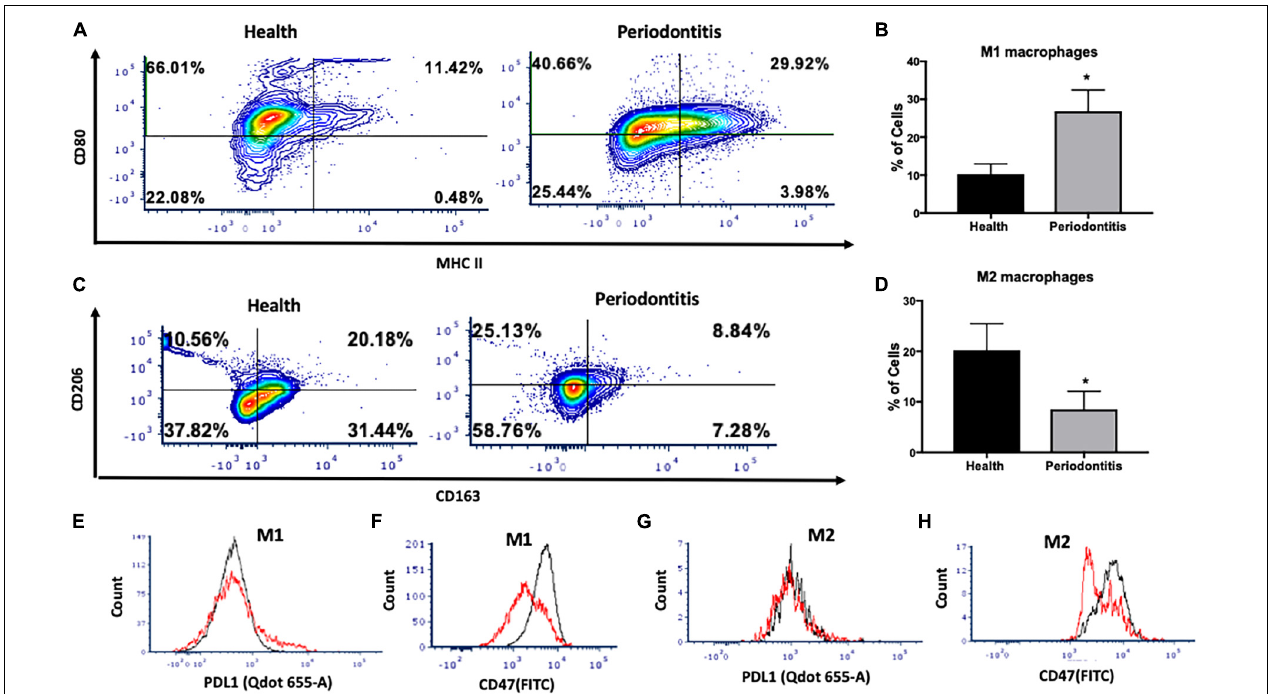
FIGURE 3 | Single cell suspensions from matched periodontitis-affected and healthy gingival tissues were prepared and stained for UV Zombie, CD45, Lin, CD64, MHC II, CD80, CD163, CD206, PDL1, CD47. (A,B) Representative counter plots of M1 macrophages (CD80 + MHC II + ). Frequency of M1 macrophages was higher in periodontitis-affected tissue compared to controls ( n = 21 pairs; p < 0.05). (C,D) Representative counter plots of M2 macrophages (CD206 + CD163 + ). Frequency of M2 macrophages was lower in periodontitis-affected tissue compared to controls ( n = 6 pairs; p < 0.05). (E,F) Flow cytometry histogram of CD47 (FITC) and PDL1 (Qdot 655-A) expression in M1 macrophages in periodontitis-affected tissue (red line) compared to the healthy tissue (black line) shows higher expression of both markers in periodontitis-affected sites. The histogram was normalized to the number of events. (G,H) Flow cytometry histogram of CD47 (FITC) and PDL1 (Qdot655-A) expression in M2 macrophages in periodontitis-affected tissue (black line) compared to the healthy tissue (red line) shows change in both markers in periodontitis affected sites in T2DM (the symbol “*” indicates p < 0.05 compared to the healthy